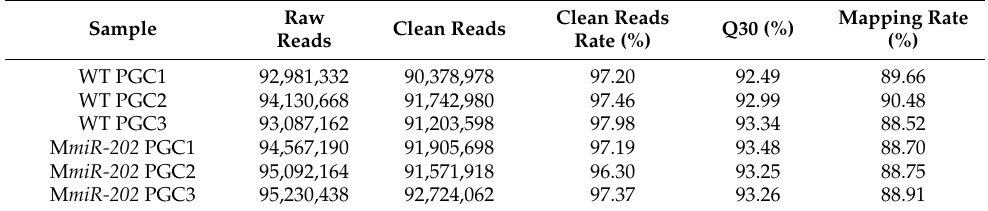
Table 1. The quality information of transcriptome